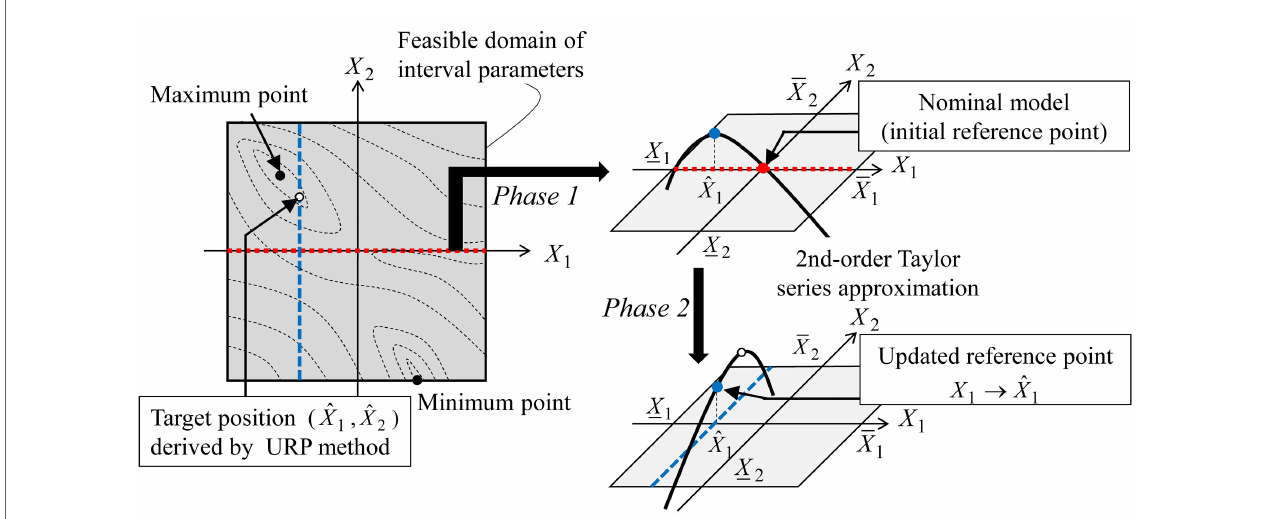
FIGURE 4 | Schematic diagram of updated-reference-point (URP) method by Fujita and Takewaki (2011) (cited from Fujita and Takewaki, 2011).